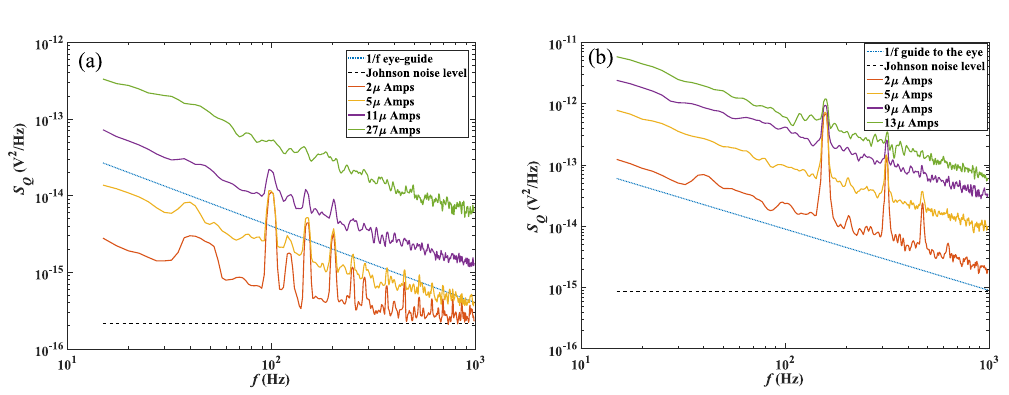
Figure 4. Hall voltage noise power, S Q , in the range 1 Hz to 1 kHz at various dc drive currents for a 1500 nm ( a ) Hall cross and for a 85 nm ( b ) Hall cross with no applied back gate voltage. The dashed lines indicate the calculated Johnson noise level for the devices. Both structures were measured at similar carrier densities of n h ~ 2.5 × 10 16 m − 2 . Peaks in the very low current spectra arise from 50 Hz (and higher harmonic) pick-up from the 230 V ac mains supply, but since these occur at discrete frequencies they do not influence the underlying 1/f noise